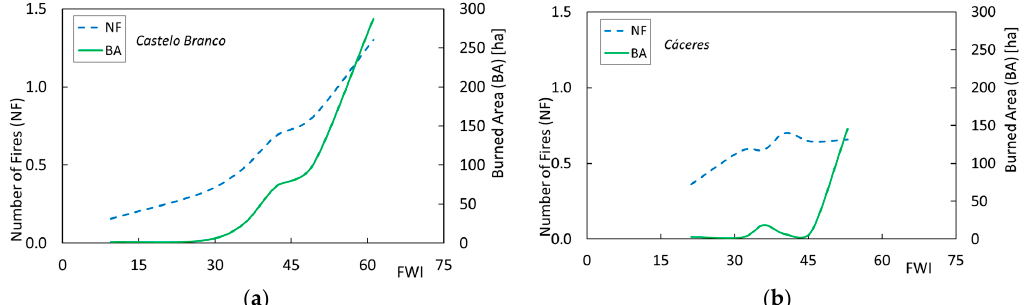
Figure A7. Average number of daily fires (NF) and burned area (BA) as a function of FWI for: ( a ) the Portuguese District of Castelo Branco and ( b ) the Spanish Province of Cáceres.